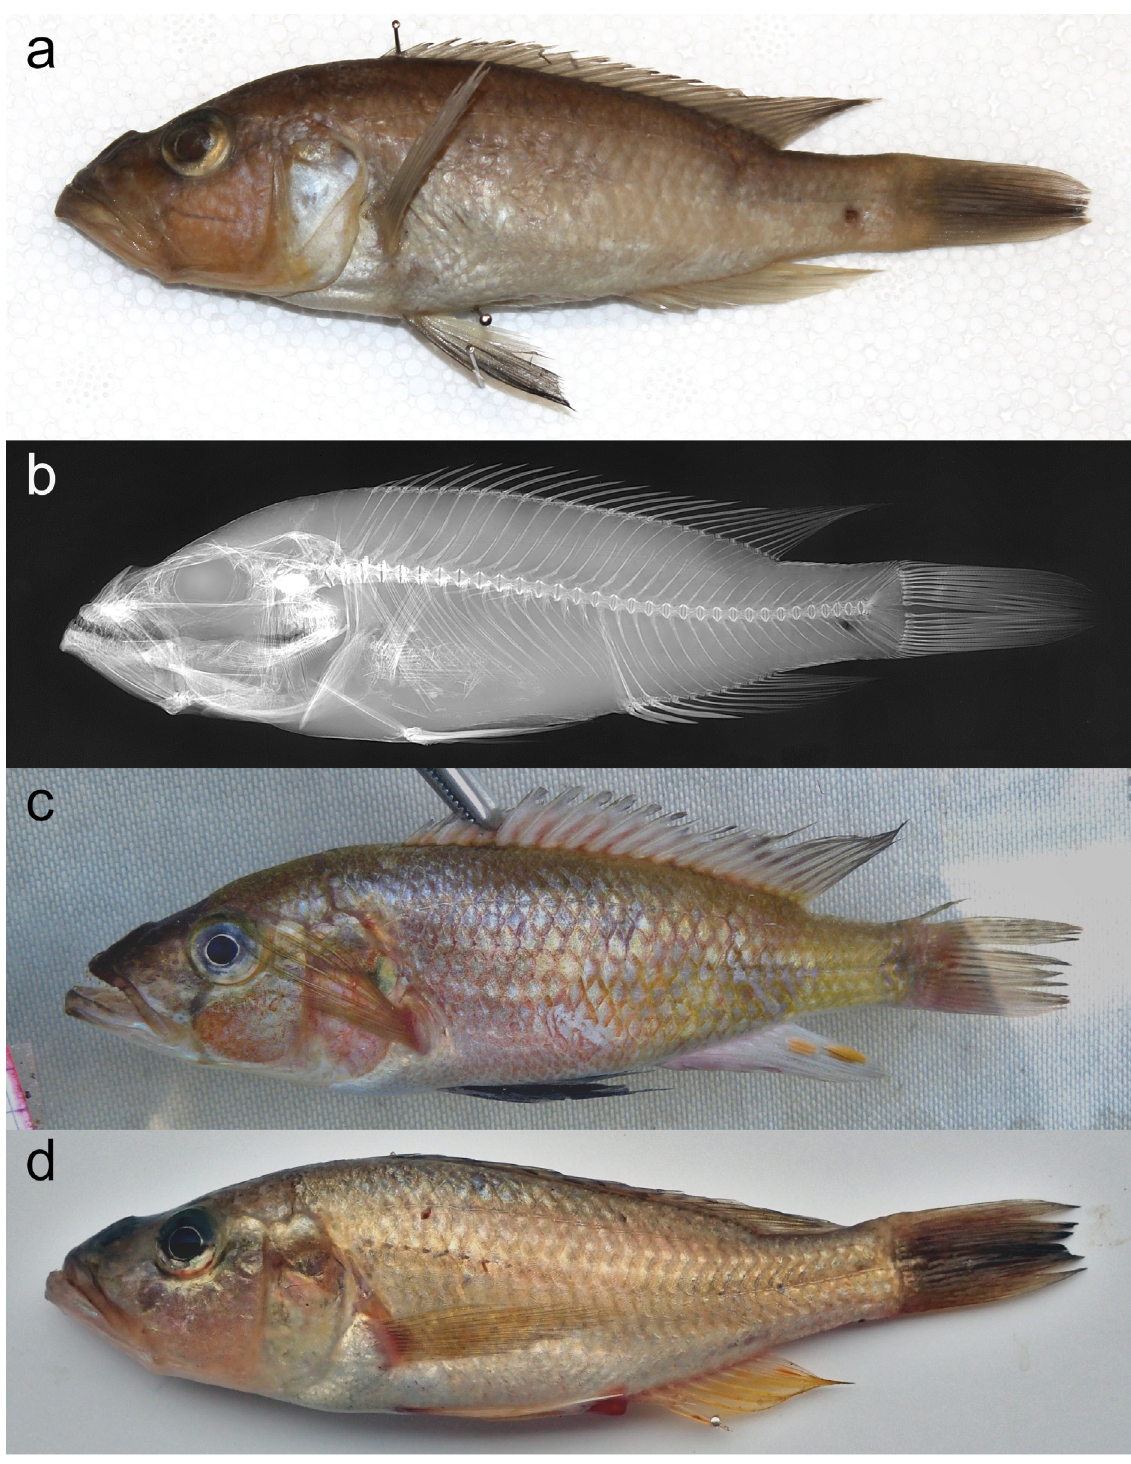
Fig. 15. Haplochromis simba sp. nov. a . Photograph of preserved holotype (RMCA 2016.035.P.0225; 105.8 mm SL). b . X-ray image of holotype. c – d . Photographs of freshly caught specimens. c . Dominant male (RMCA 2016.035.P.0224; 97.9 mm SL). d . Female (RMCA 2018.008.P.0348; 109.0 mm SL) to illustrate the live colour patterns. The contrast was slightly